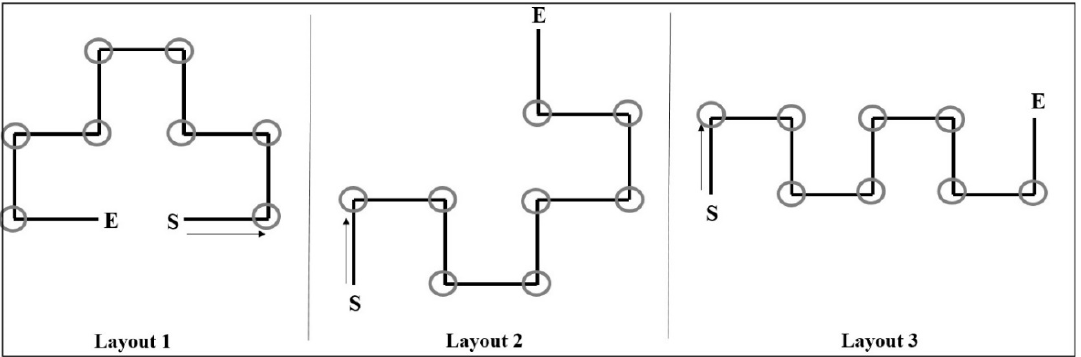
Figure 1. The figure depicts the three different layouts. S = starting positions; E = end of the route. The grey circles indicate where the images were put along the route. Virtual routes had the same length and temporal duration.